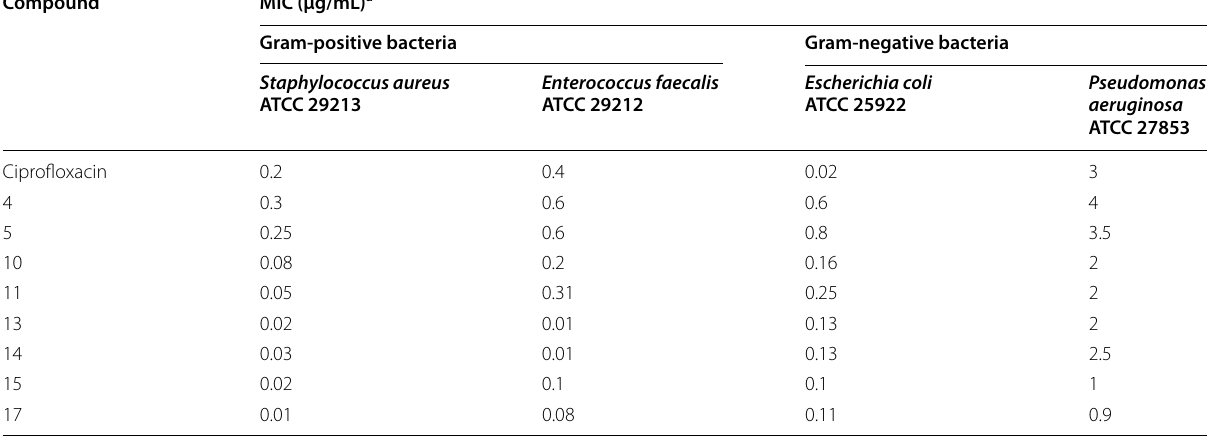
a MIC, minimum inhibitory concentration